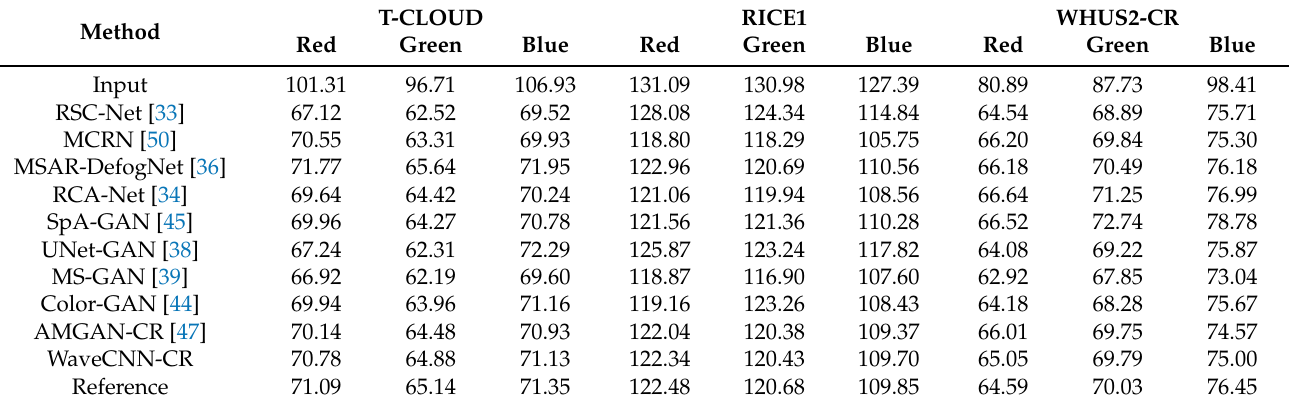
Table 9. Statistical results of the average pixel values of the input cloudy images, reference images, and results of different methods on the three test